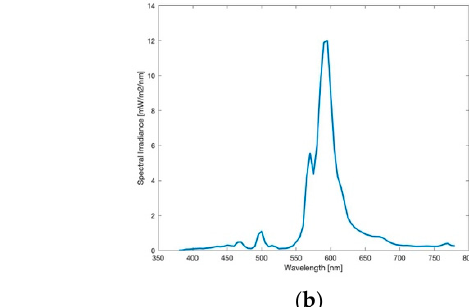
Figure 9. ( a ) Image of the lantern during daytime; ( b ) Spectrum of lamp observed.